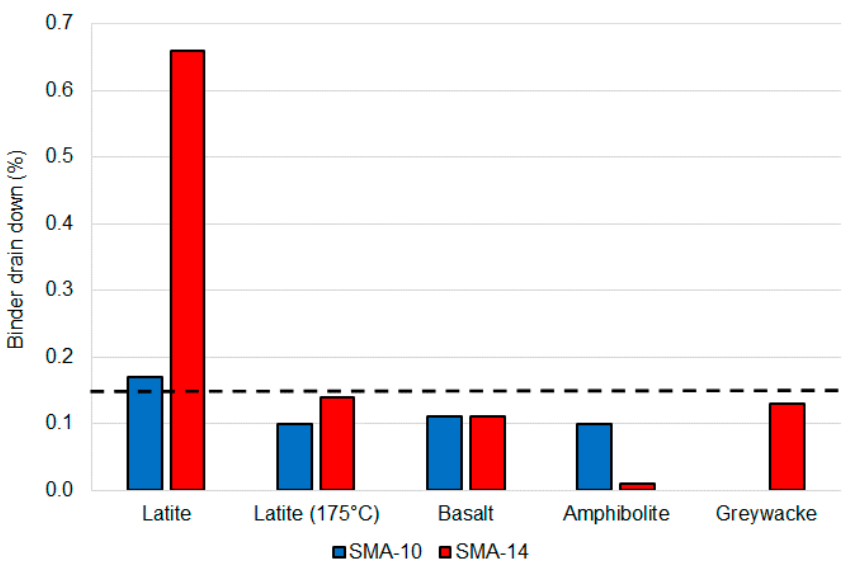
Figure 12. SMA binder drain down at 185 °C (except where noted) summary.